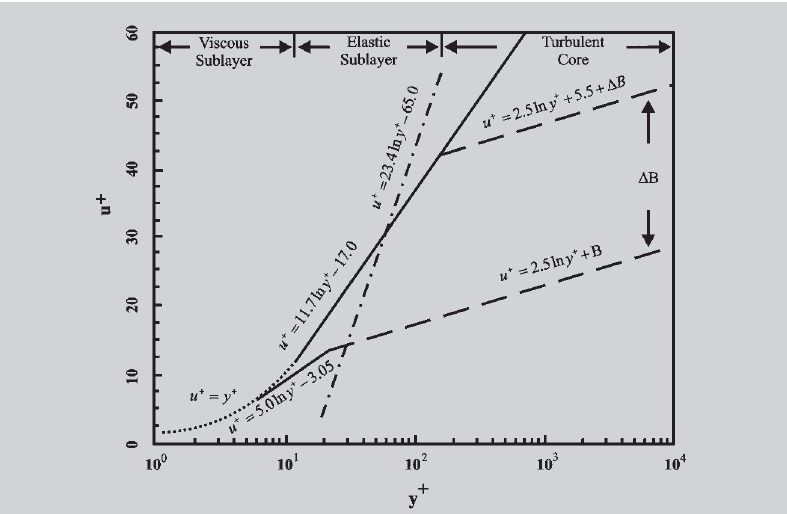
Figure 4: Three-layer model for dimensionless velocity profile for turbulent